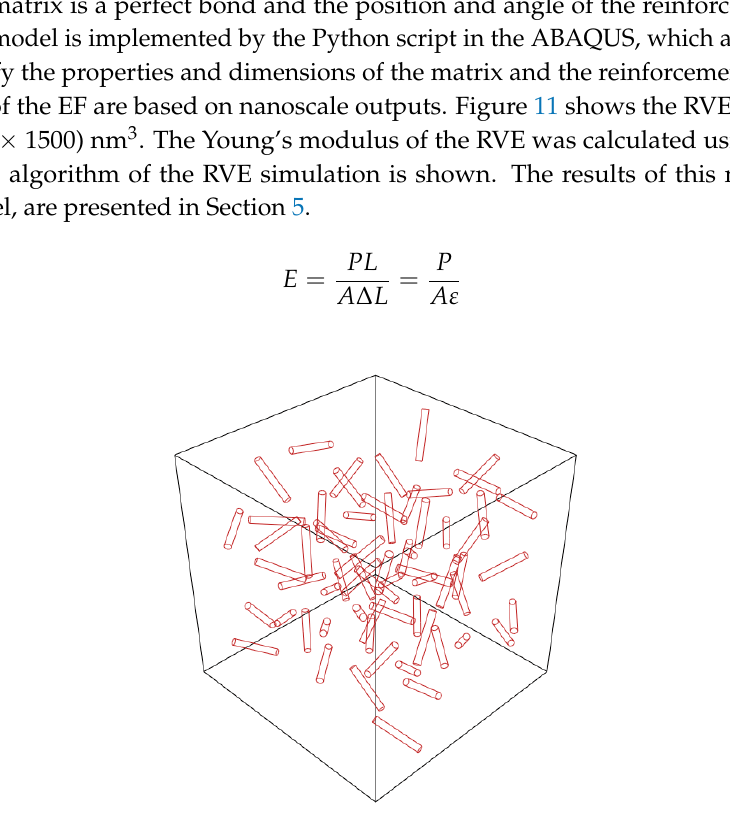
Figure 11. 3D view of the representative volume element (RVE) with the volume of 1500 × 1500 × 1500 nm 3 and the random dispersion of the equivalent fibers.